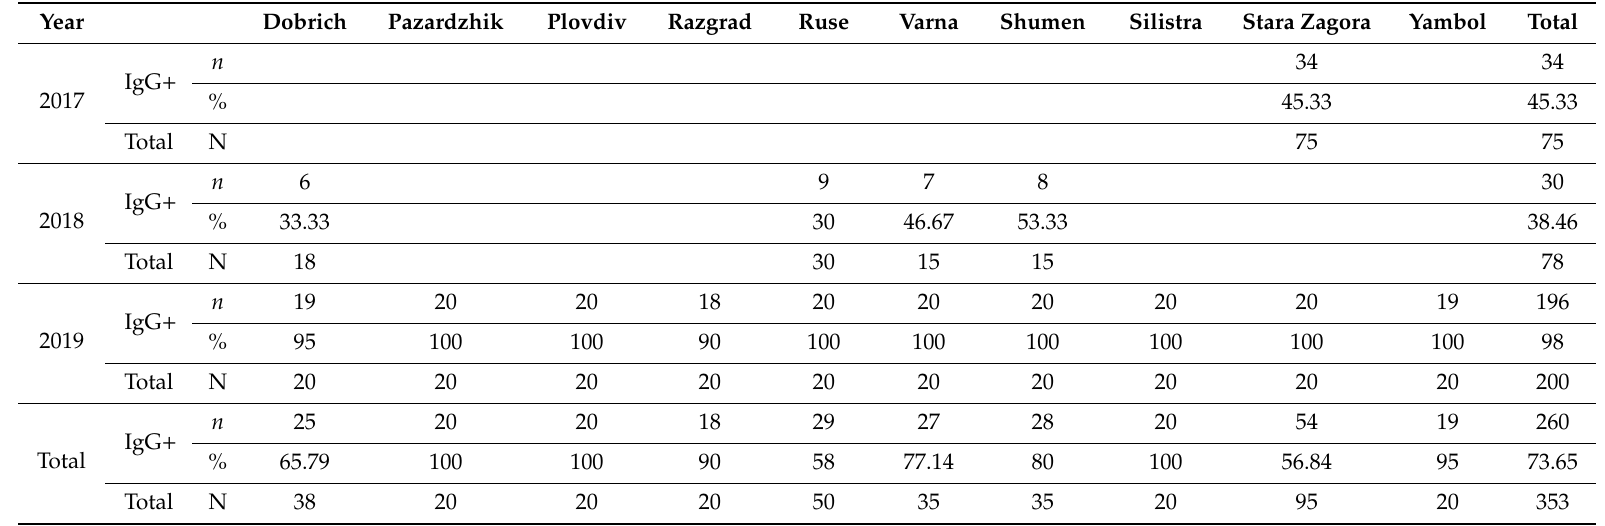
Table 1. Anti-HEV IgG among slaughter-aged pigs (6-month-old) from di ff erent Bulgarian districts during 2017, 2018, and 2019. N designates the number of total samples; n , the number of positive samples; the districts are listed in alphabetical